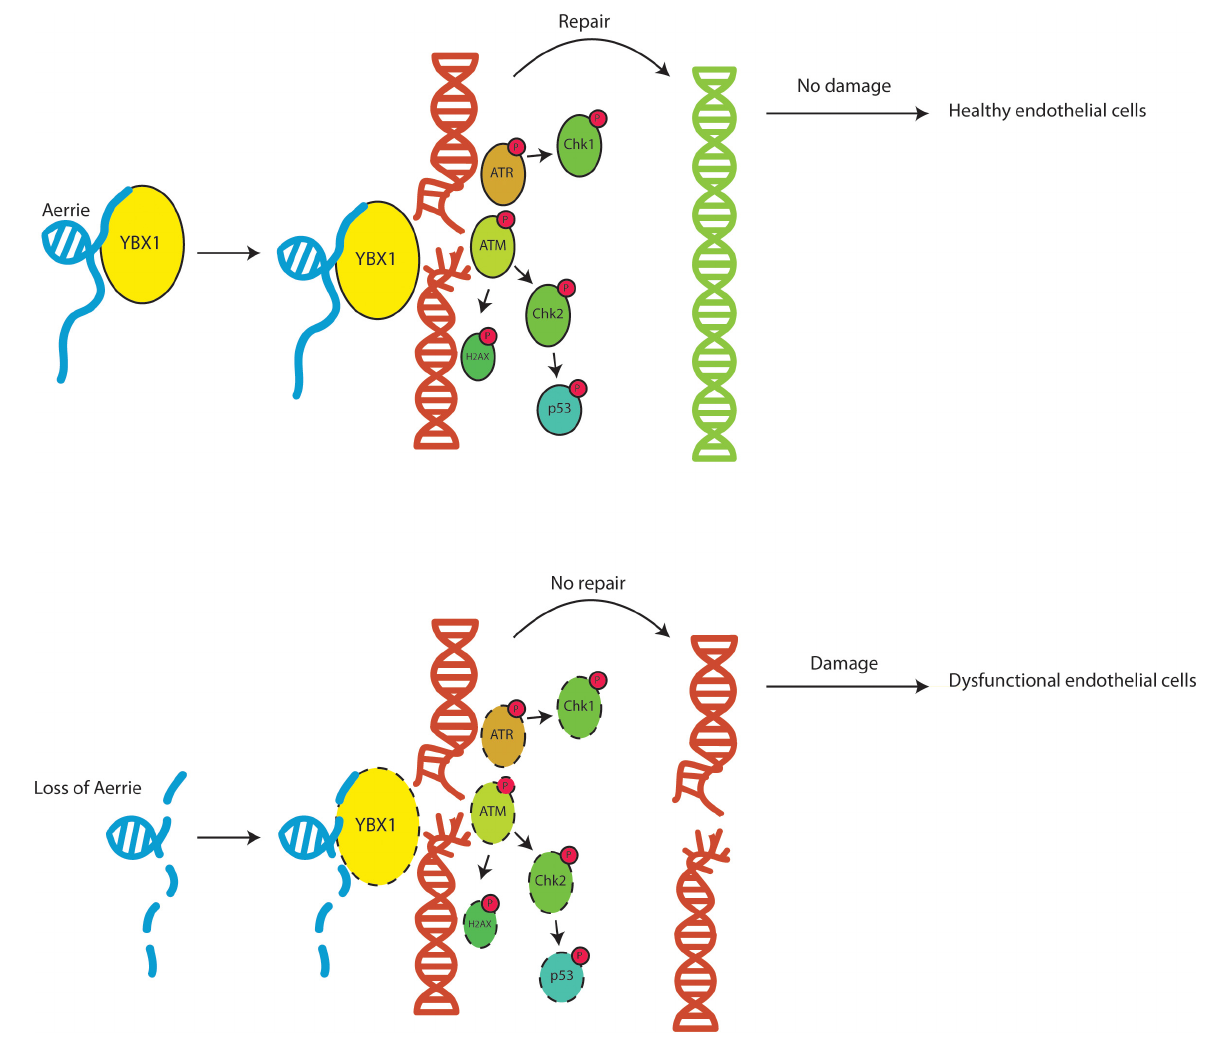
FIGURE 7 | Schematic overview of the function of lncRNA Aerrie and YBX1. Aerrie as an important factor in genomic stability and as a binding partner to YBX1 in responding to genomic stress in endothelial